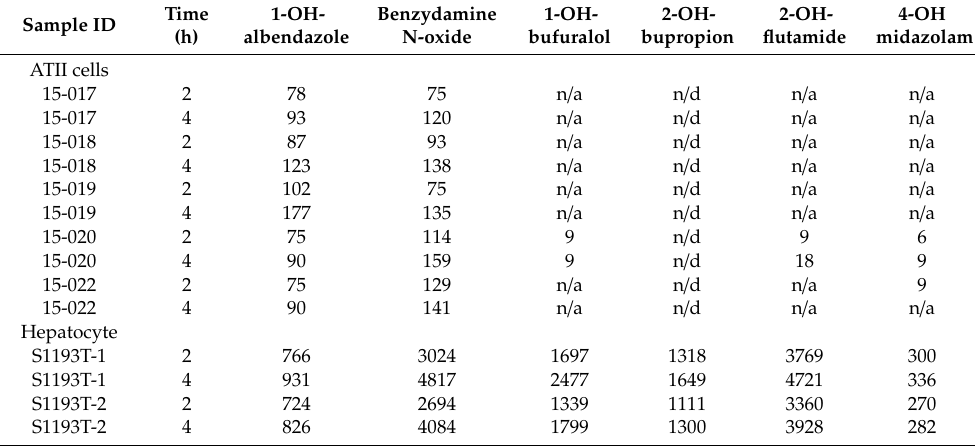
Table 4. Rate of metabolite formation, (pmol / million cells) measured by UPLC quadropole time of flight system (UPLC-QToF) after incubation of drug-metabolizing enzyme substrates with human ATII cells (ten individual donors) and human hepatocytes (four individual donors). Legend: n / a, not applicable (below limit of quantification of 1 nM); n / d, not